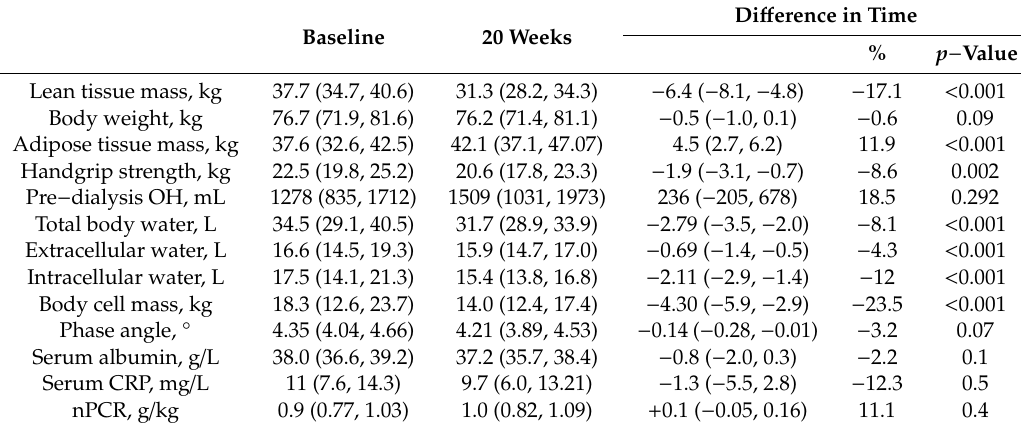
Table 2. Change in primary and secondary study parameters from mixed models analysis *.